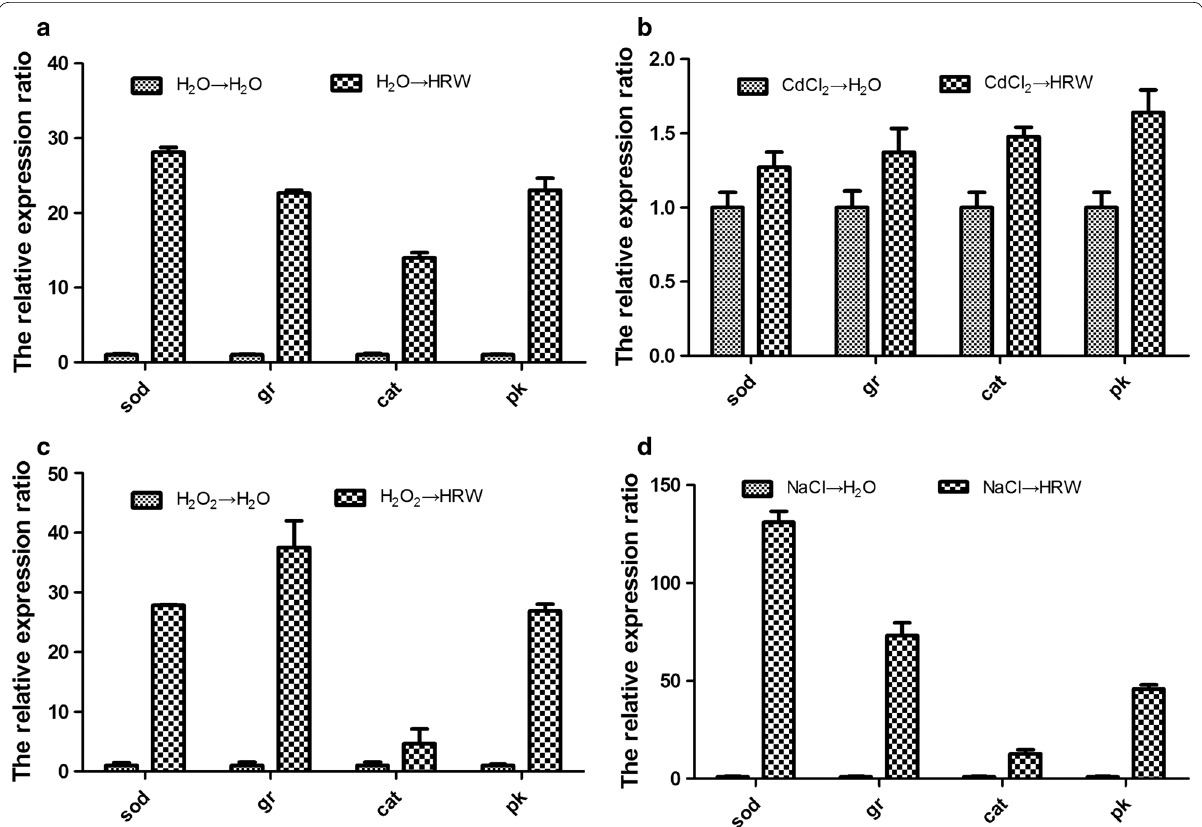
Fig. 7 Effects of HRW treatment on gene expressions of sod ( a ), cat ( b ), gr ( c ) and noxR ( d ) in the mycelia of Hypsizygus marmoreus upon CdCl 2 , NaCl and H 2 O 2 stresses. Expression levels of corresponding genes are presented relative to the control samples. Data are mean independent